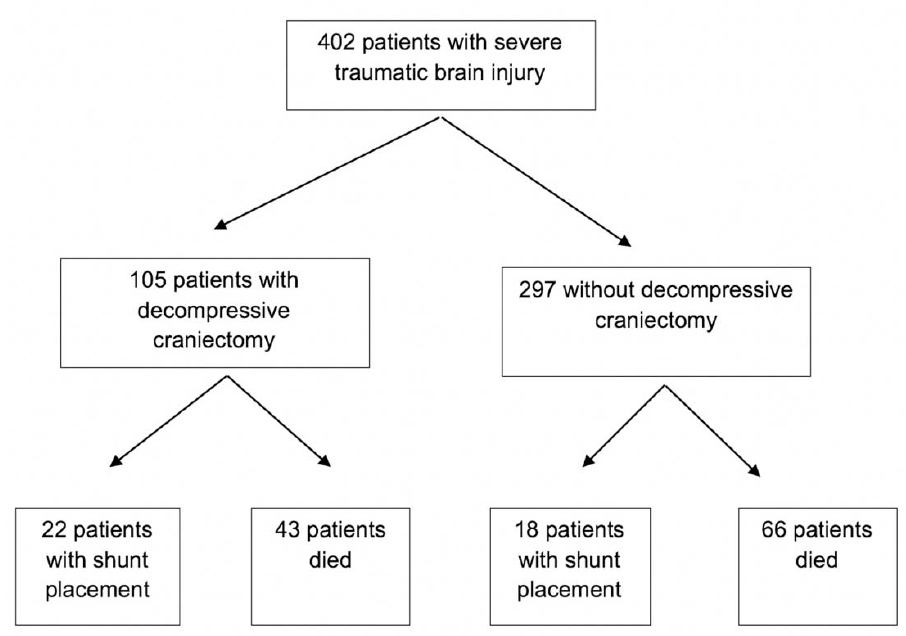
Figure 1. Flow chart for enrolled severe TBI patients who were enrolled in the study. Table 1. Baseline demographics and clinical characteristics of severe TBI patients.